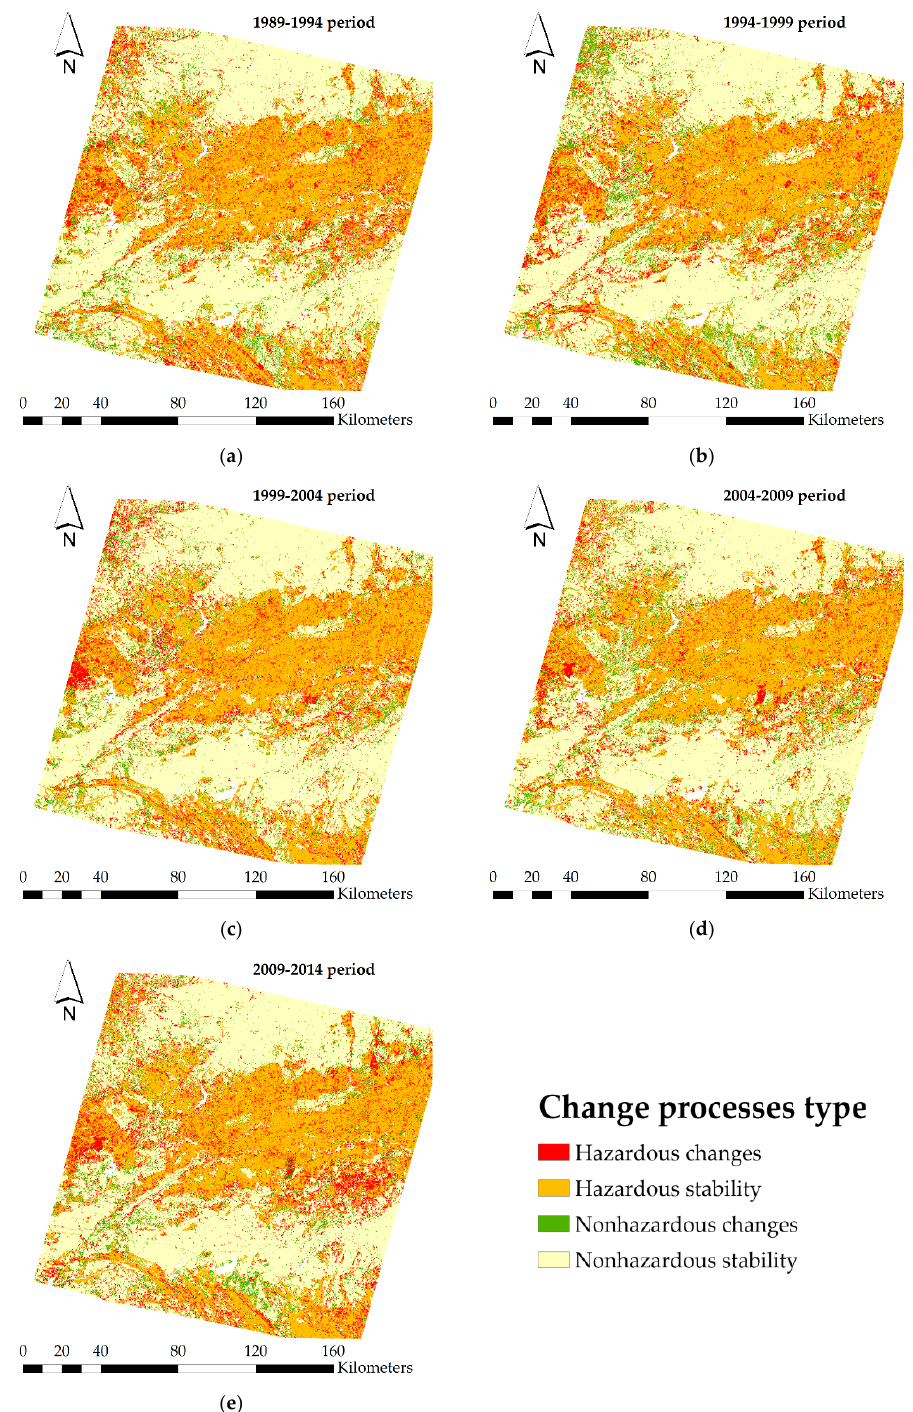
Figure A4. Spatial distribution of the LULC change processes categorized by their hazardousness to fire for: ( a ) 1989 – 1994 period ( b ) 1994 – 1999 period ( c ) 1999 – 2004 period ( d ) 2004 – 2009 period, and ( e ) 2009 – 2014 period.